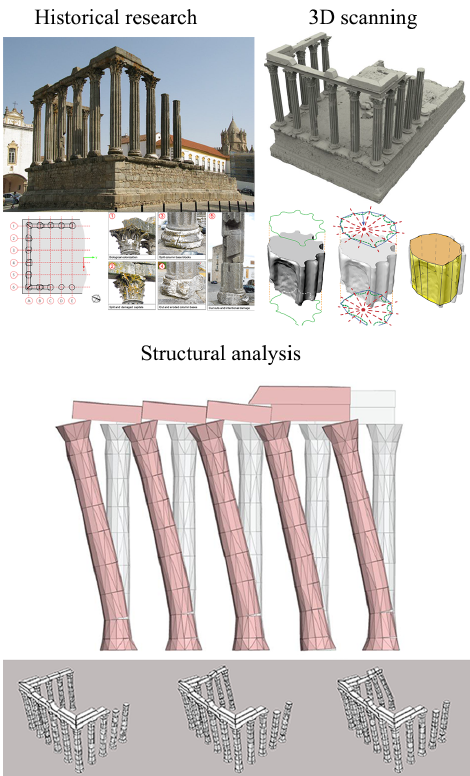
Figure 9. Conservation of cultural heritage buildings, methodology and application to case studies: Roman Temple of Évora in Portugal